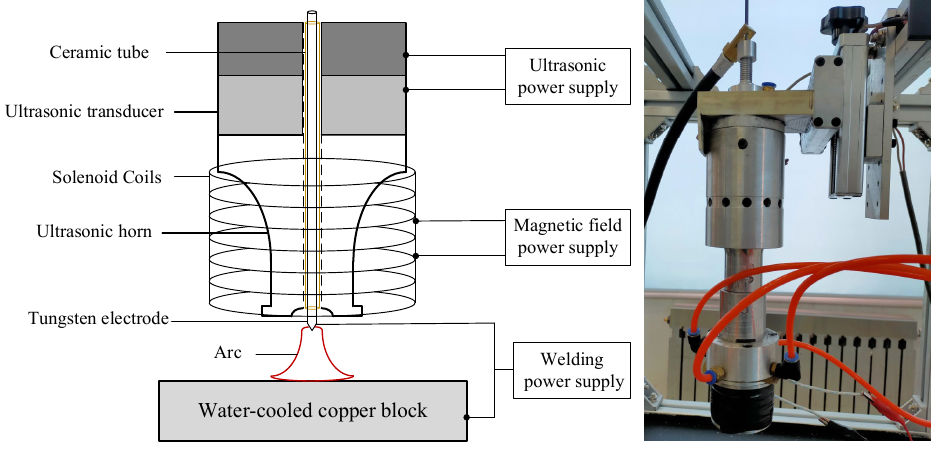
Figure 1. U-M-GTAW system.